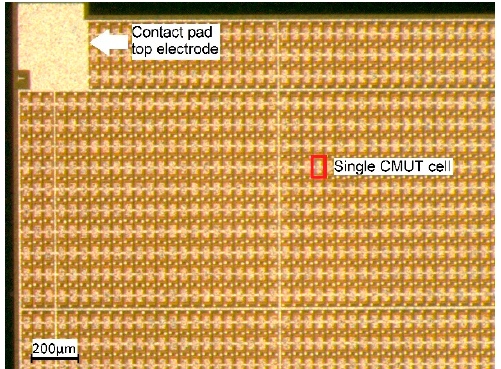
Figure 2. Section of the fabricated CMUT chip, edge length of a single membrane: 80 µm × 40 µm. membrane thickness: 850 nm (600 nm-Si 3 N 4 , 250 nm-Al). Gap-height: 200 nm. With transmission measurements in Fluorinert FC-72, a full width at half maximum bandwidth (FWHM) of 102% and a central frequency of 2.08 MHz were determined. The resulting frequency spectrum for 60 V DC bias voltage and 10 V AC signal voltage is shown in Figure 3 .